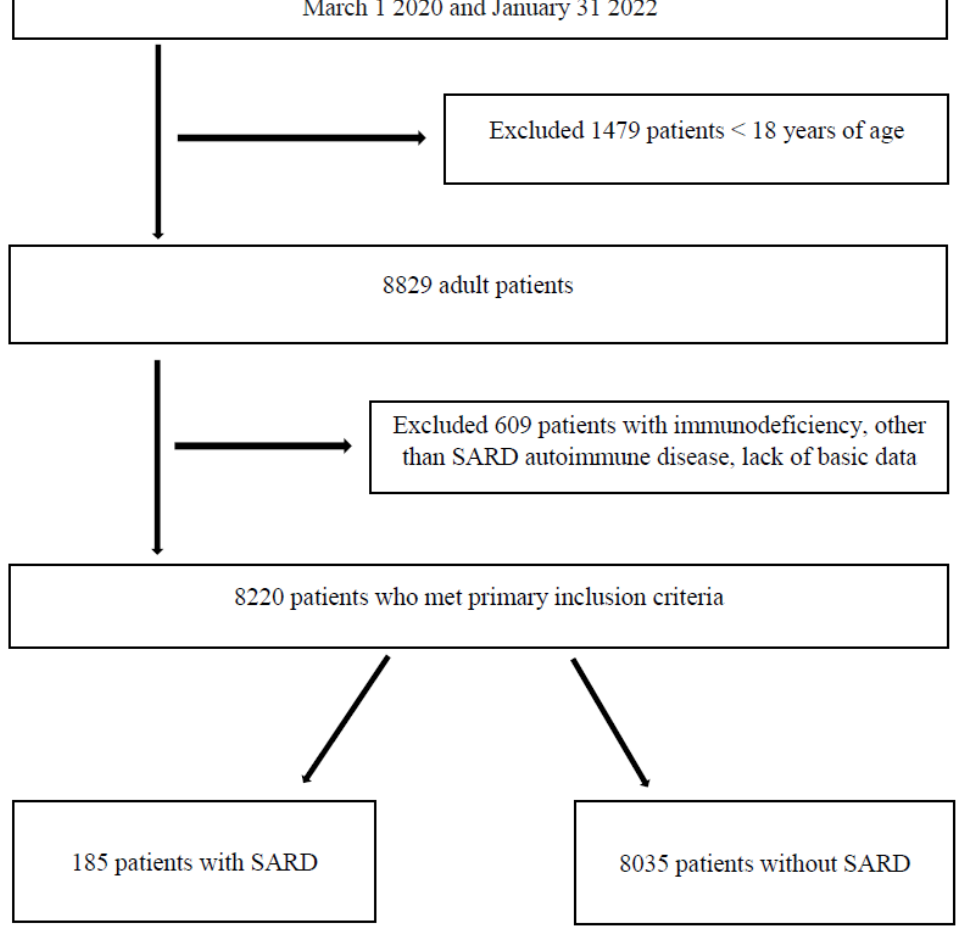
Figure 1. Flowchart of inclusion on the patients. Abbreviations: COVID-19 (coronavirus disease 2019); SARD, systemic autoimmune rheumatic